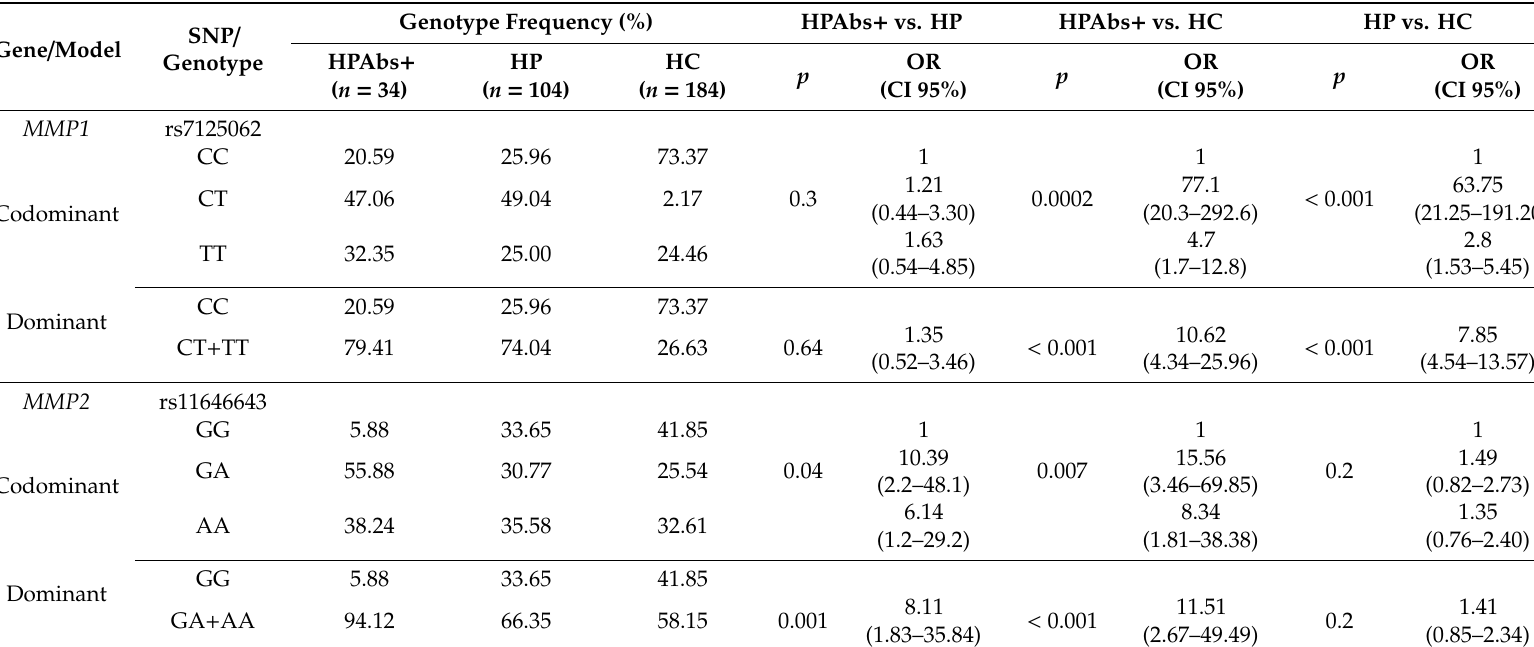
Table 5. SNPs and associated genotypes in the genes MMP1 and MMP2 in patients with hypersensitivity pneumonitis versus hypersensitivity pneumonitis with positive